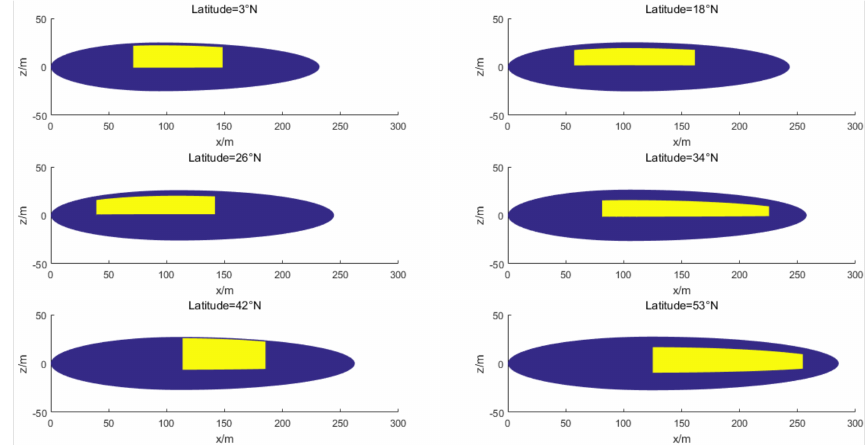
Figure 12. Envelope and solar array geometry for winter solstice in different latitude.